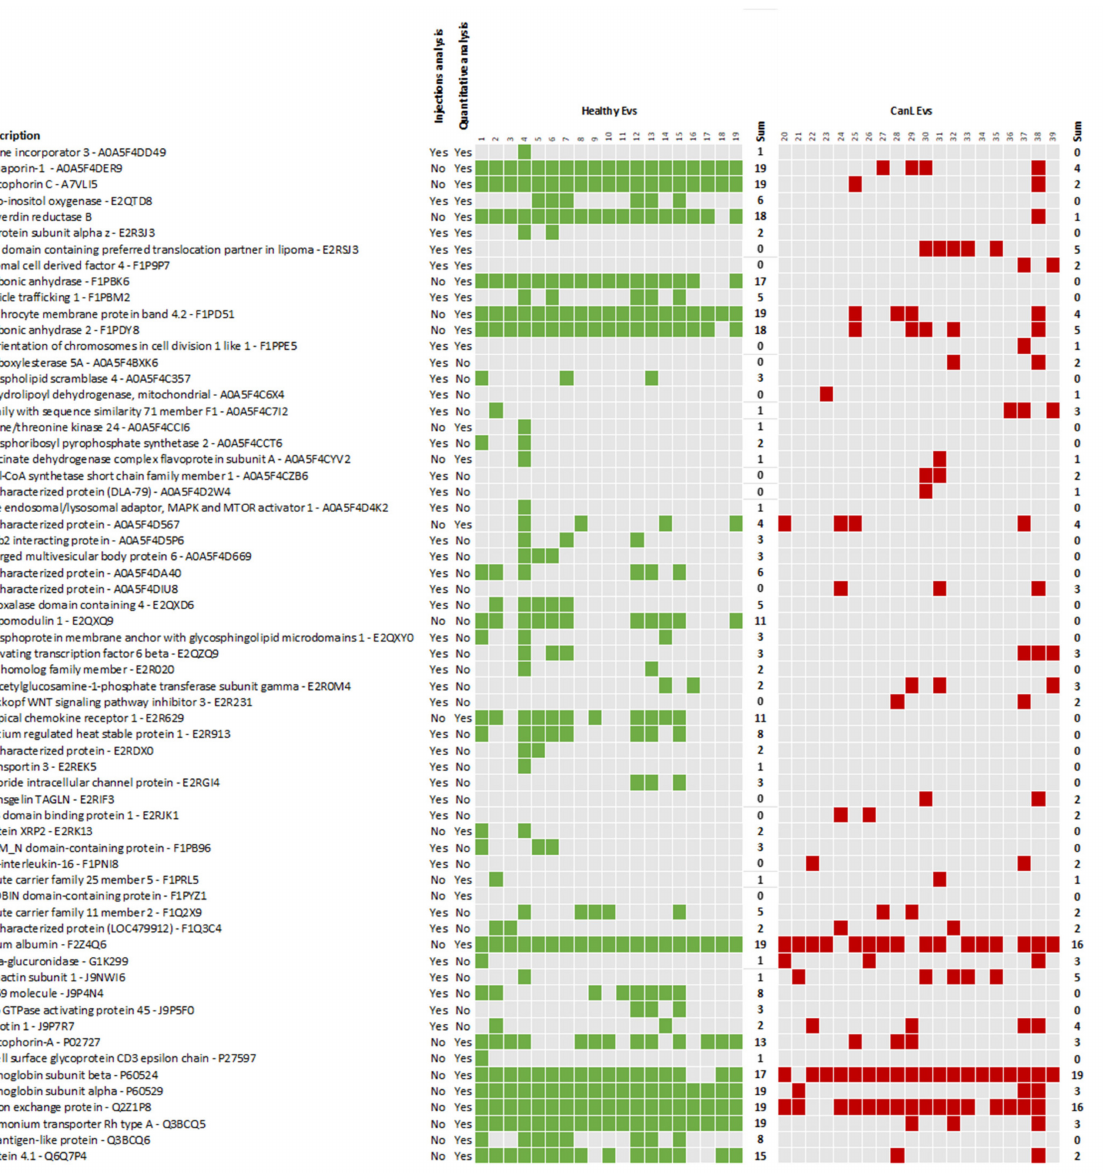
Figure 7. Detection of the most promising proteins present in individual samples. The selected proteins include all differentially abundant proteins identified in the quantitative analysis and the 40 proteins that were mostly detected in either the 48 injections from 19 Healthy dogs or the 52 injections from 20 CanL dogs. The second and third columns indicate if the proteins were identified by injection analysis, quantitative analysis or by both approaches. The presence of green (Healthy group) or red (CanL group) colours associated to individual proteins represents the detection of that protein in the sample with at least 1 unique